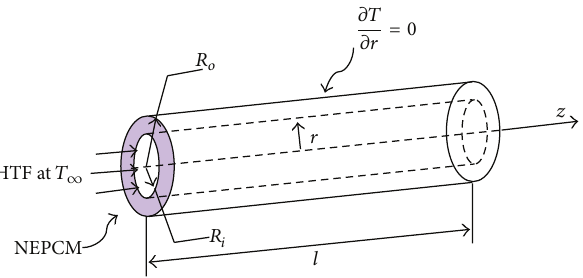
Figure 1: Physical model of cylindrical shell